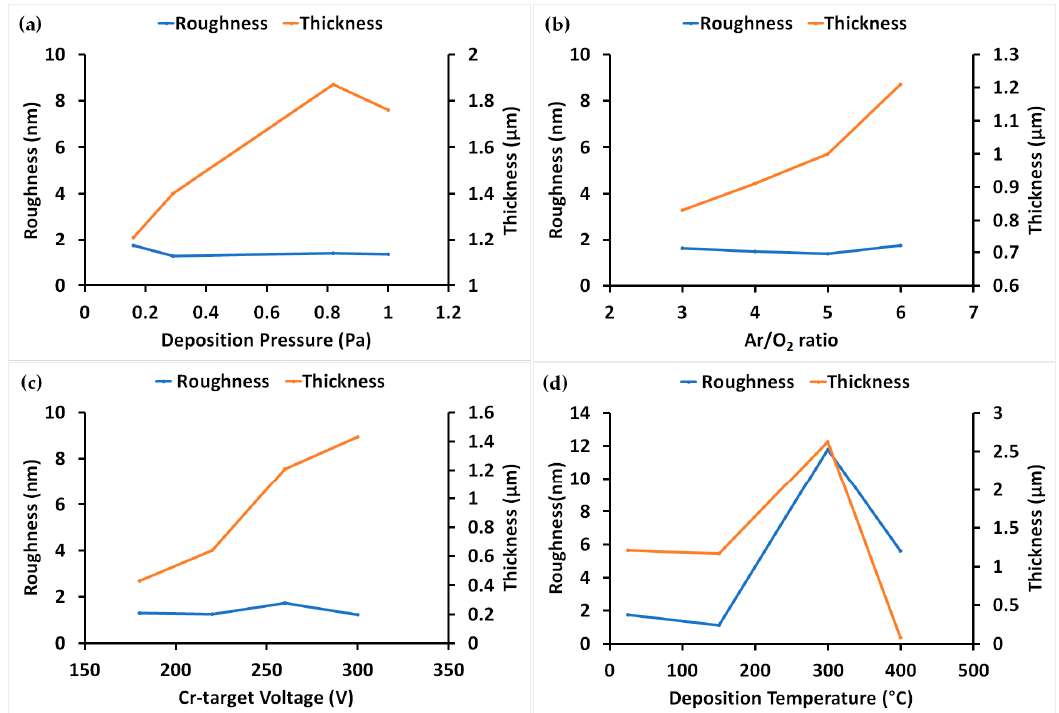
Figure 1. The effect of deposition parameters on the roughness ( R a ) and thickness of chromium oxide coatings: ( a ) Pressure; ( b ) Ar/O 2 ratio; ( c ) Cr-target voltage; and ( d ) Temperature. Standard deviations are too small to be seen in the graphs.